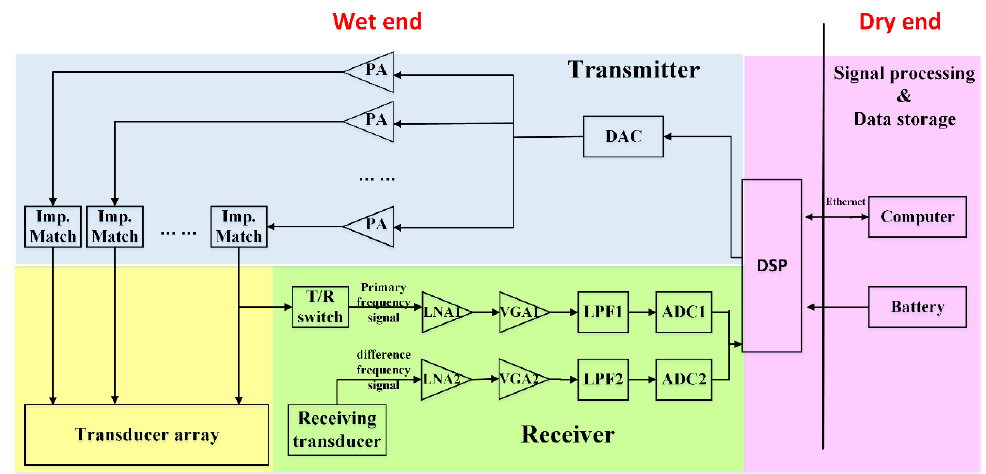
Figure 8. System configuration of a parametric array sub-bottom profiler.